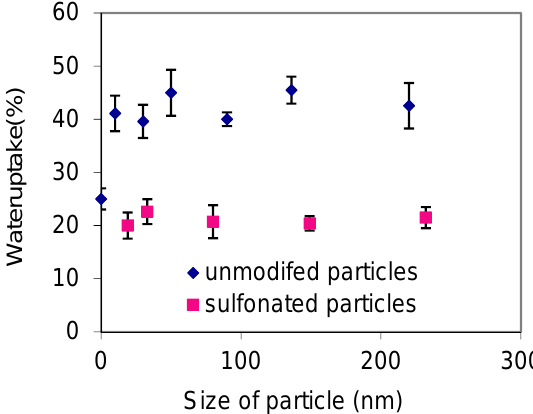
Figure 1. Water uptake for PNSS (blue diamonds) and SPNSS (red squares) membranes as a function of particle size.